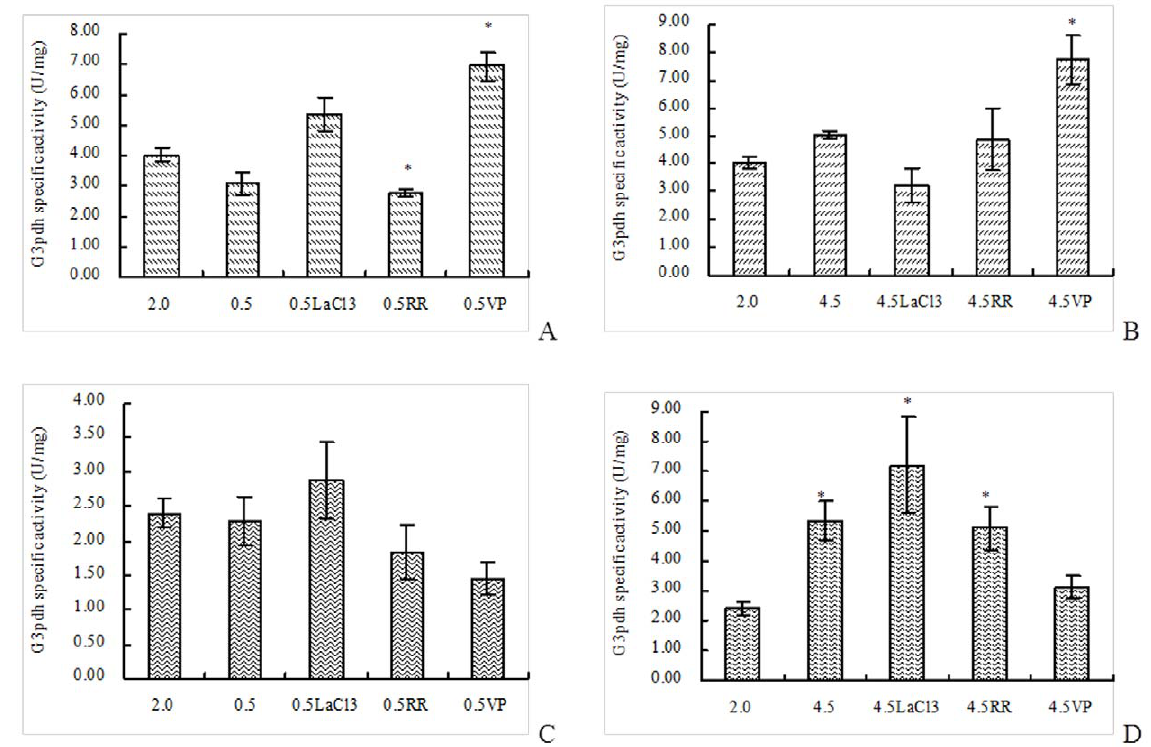
Figure 4. Effect of Ca 2 + channel blockers on (NAD + )-dependent G3pdh activity in D.salina under hypoosmotic or hyperosmotic stress. A: Forward reaction activity on hypoosmotic stress; B: Forward reaction activity on hyperosmotic stress; C: Backward reaction activity on hypoosmotic stress; D: Backward reaction activity on hyperosmotic stress. Columns represent the means of three replicated studies in each sample, with the SD of the means (T test, p , 0.05). The significance of the differences between the control (2.0) and test values were tested by using one-way ANOVA. *, p , 0.05 vs control.